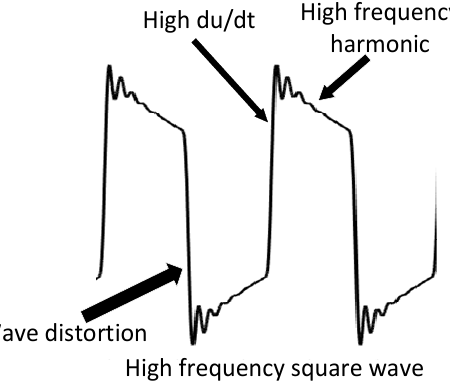
Figure 1. The typical winding voltage waveform of the high-frequency reactor in power electronic equipment.